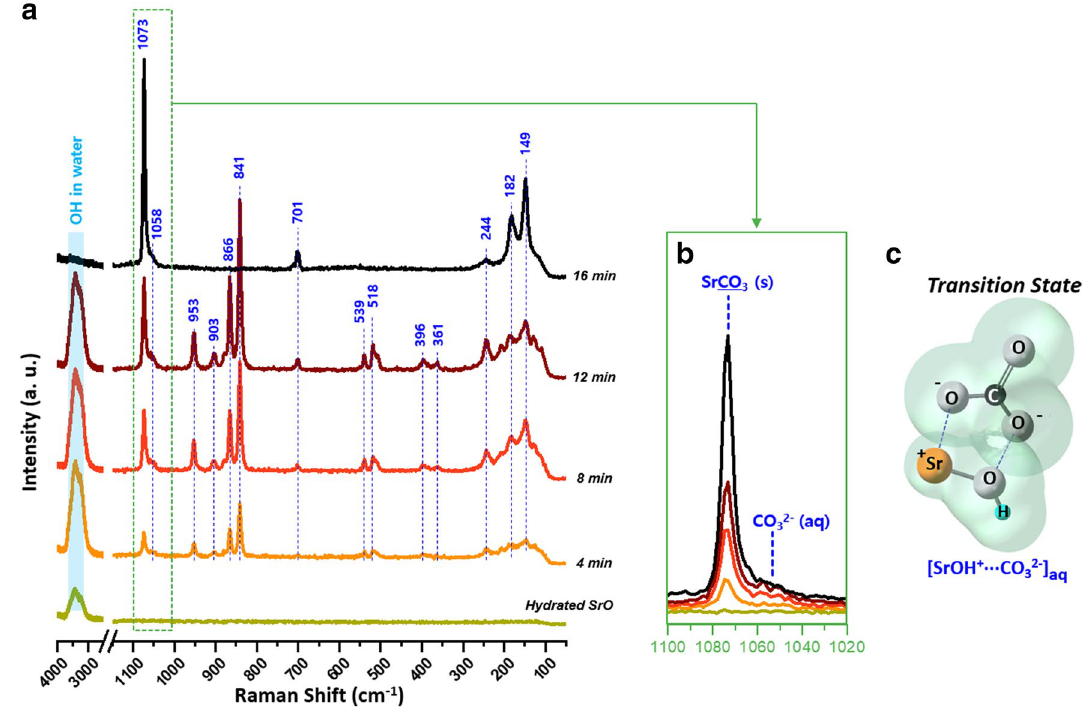
Figure 5. ( a ) Raman spectra of hydrated SrO in ambient air, recorded over time (0, 4, 8, 12, and 16 min). ( b ) Superimposed Raman spectra at the range of 1020–1100 cm −1 . ( c ) A structure of the transition-state intermediate, SrOH + ⋯ CO 3 2− . Vibration modes of the Raman spectra are displayed in Supplementary Table